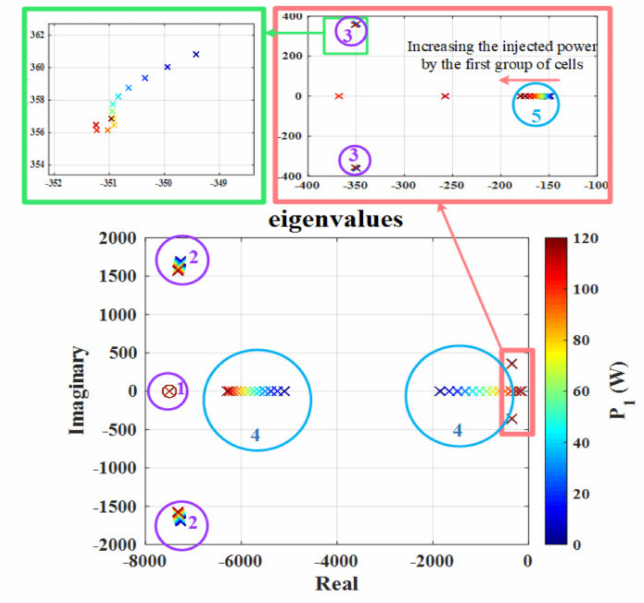
Figure 16. Eigenvalues of the closed-loop system by changing the injected power of the first stack while the other stacks inject the nominal power of 126